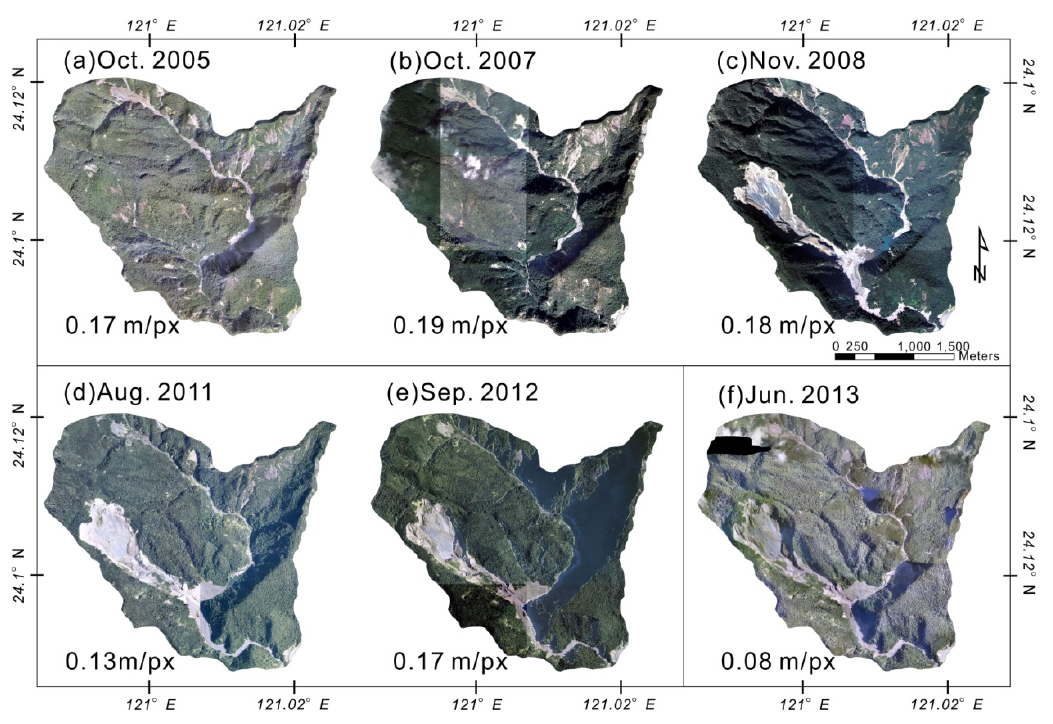
Figure 4. Orthoimages generated using various aerial photogrammetry cameras from six periods. ( a – c ) historical aerial photogrammetry images; ( d , e ) taken under the ALS survey task; and ( f ) a